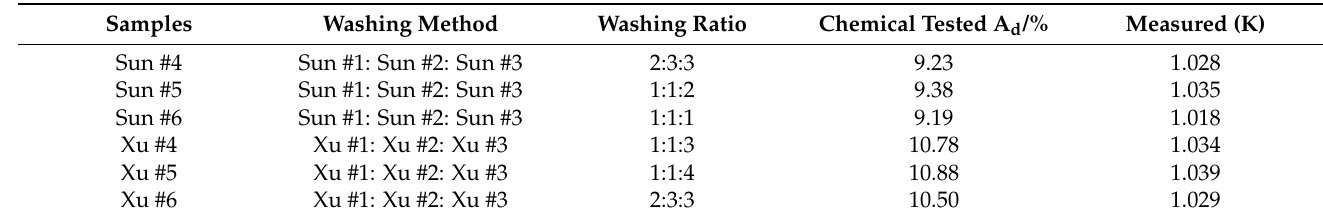
Table 6. Data of mixed coal from the same mine (Suntuan and Xutuan mines).